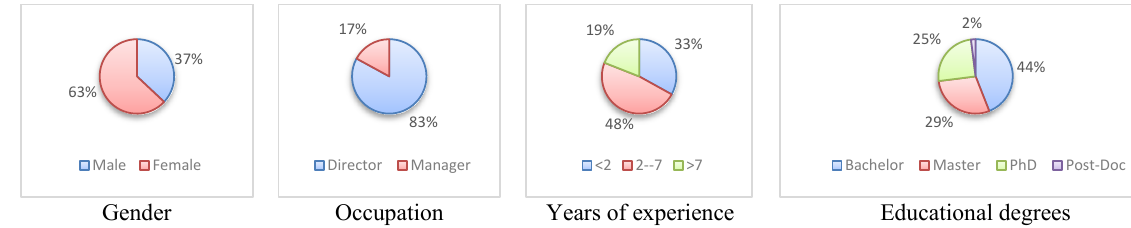
Fig. 1. Profile of